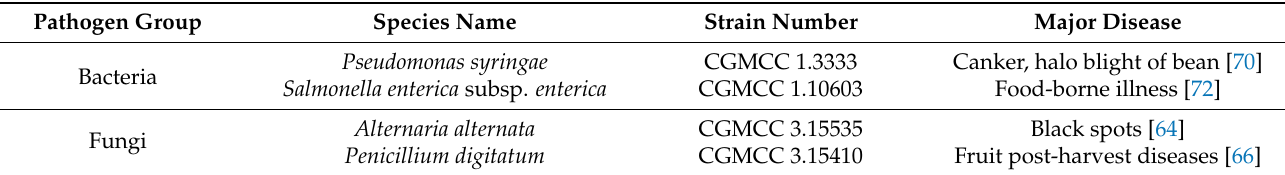
Table 3. Information of the pathogens obtained from